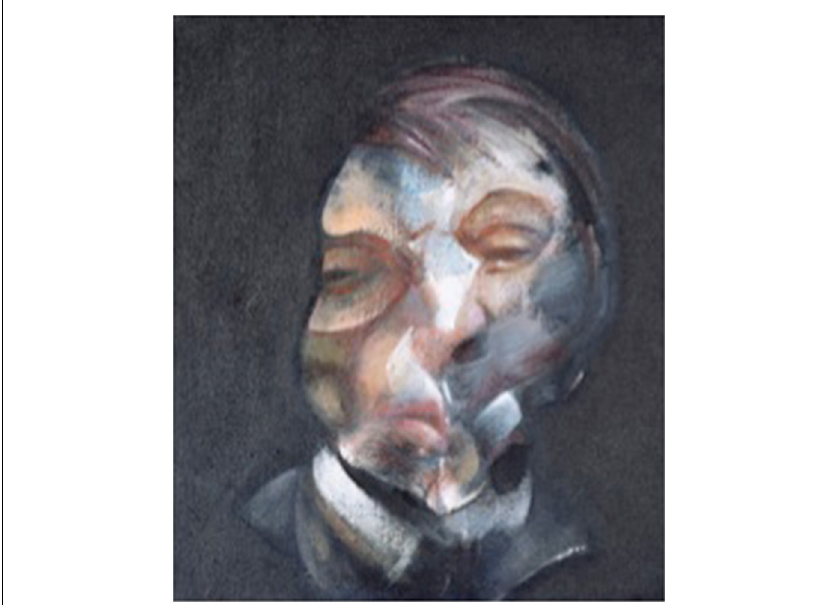
FIGURE 1 | Francis Bacon—Self-portrait 1971. Centre Georges Pompidou, Paris, France. © The Estate of Francis Bacon/All rights reserved/ADAGP, Paris 2014.